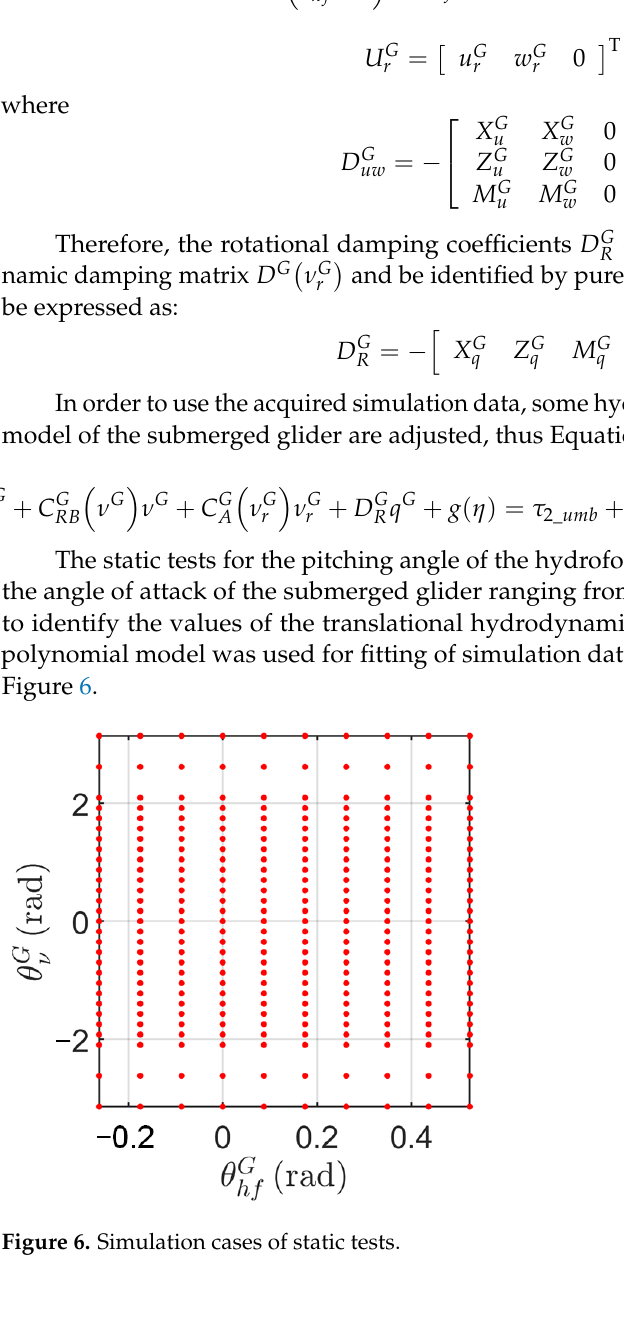
( b ) ( c ) Figure 7. The simulation and fitting results of static tests: ( a ) surge force; ( b ) heave force; ( c ) pitch moment.